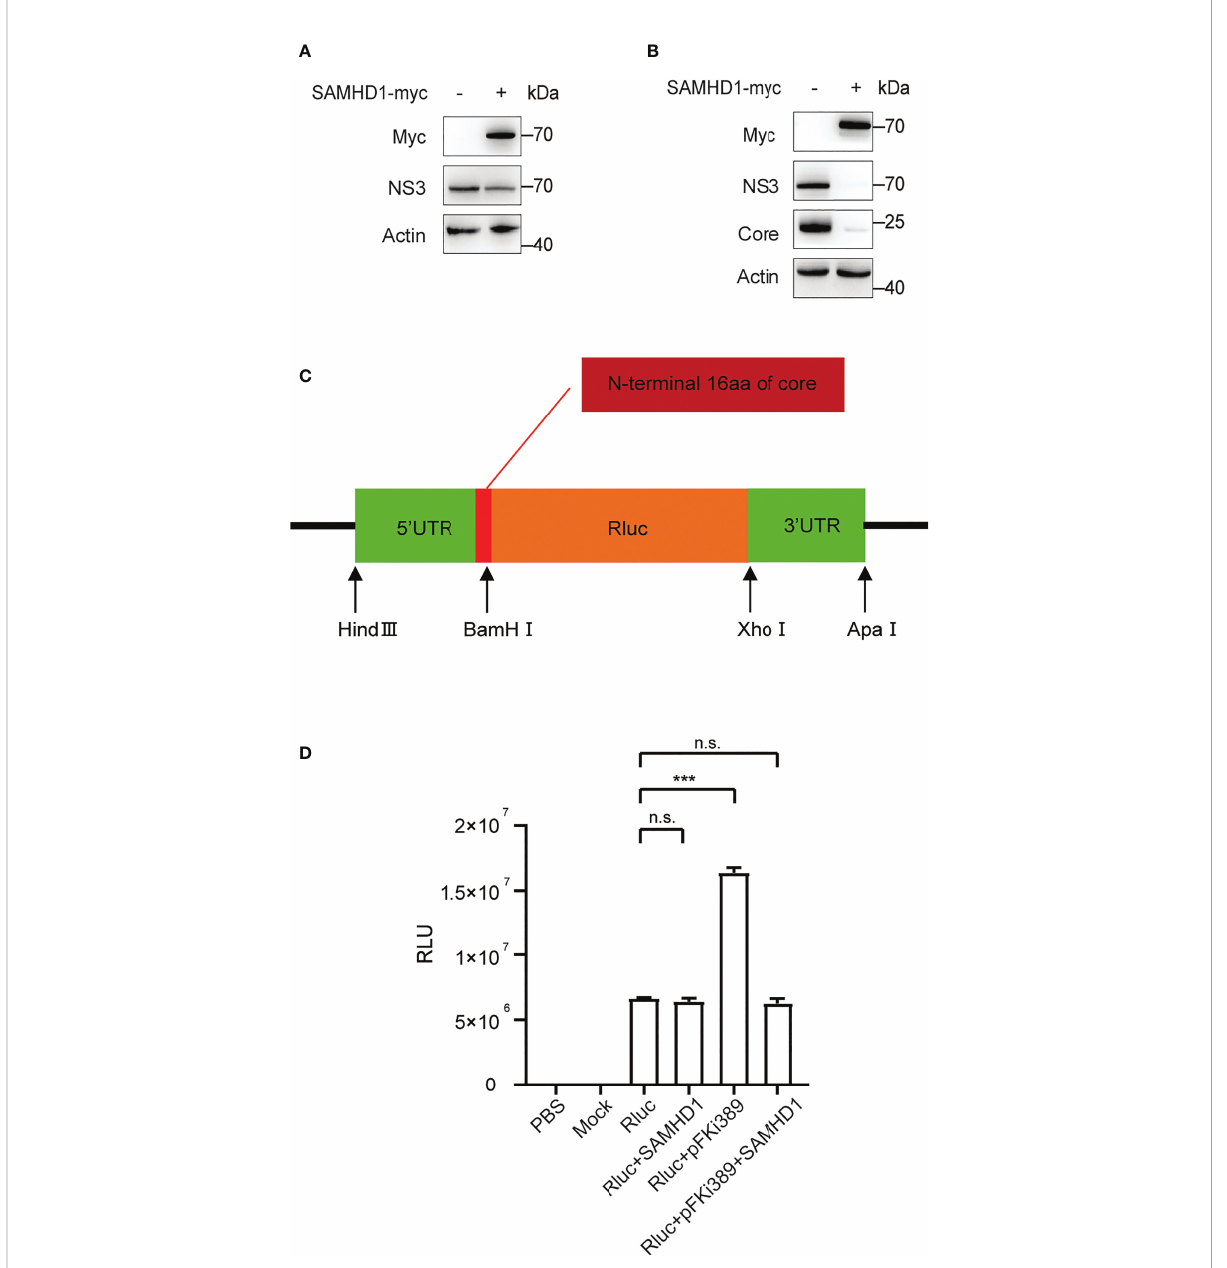
FIGURE 6 Effect of SAMHD1 on HCV replication and translation. (A) Huh7 replicon cells were transfected with plasmid expressing SAMHD1 for 48 h. Cell lysates were analyzed by Western blotting to determine the expression level of NS3 protein. Data are representative of three independent experiments. (B) Huh7.5.1 cells were co-transfected with plasmid of SAMHD1 and JFH1 HCVcc RNA transcripted in vitro . At 48 h post- transfection, HCV NS3 and core proteins in cells were detected by Western blotting to determine inhibition on HCV replication by SAMHD1. This experiment has been repeated three times. (C) Schematic presentation of HCV IRES-mediated luciferase reporter system. (D) pFKi389 containing all non-structural proteins was co-transfected with or without pSAMHD1-myc into Huh7.5.1 cells; after 24 h incubation, all cells of test groups but not control groups were transfected with HCV IRES-mediated luciferase mRNA for another 24 h. The values of Renilla luciferase (RLU) activity were measured and used to assess translation or replication level of HCV RNA under circumstances of SAMHD1 overexpression. Data are indicated as mean ± SD ( n = 3). ns, not signi fi cant;